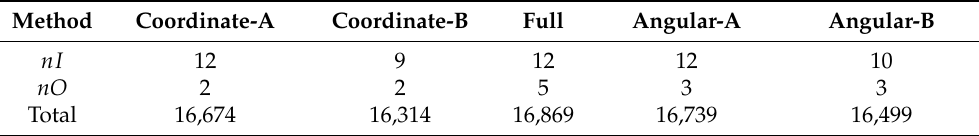
Table 9. Number of TCN parameters according to five combinations of variable sets.